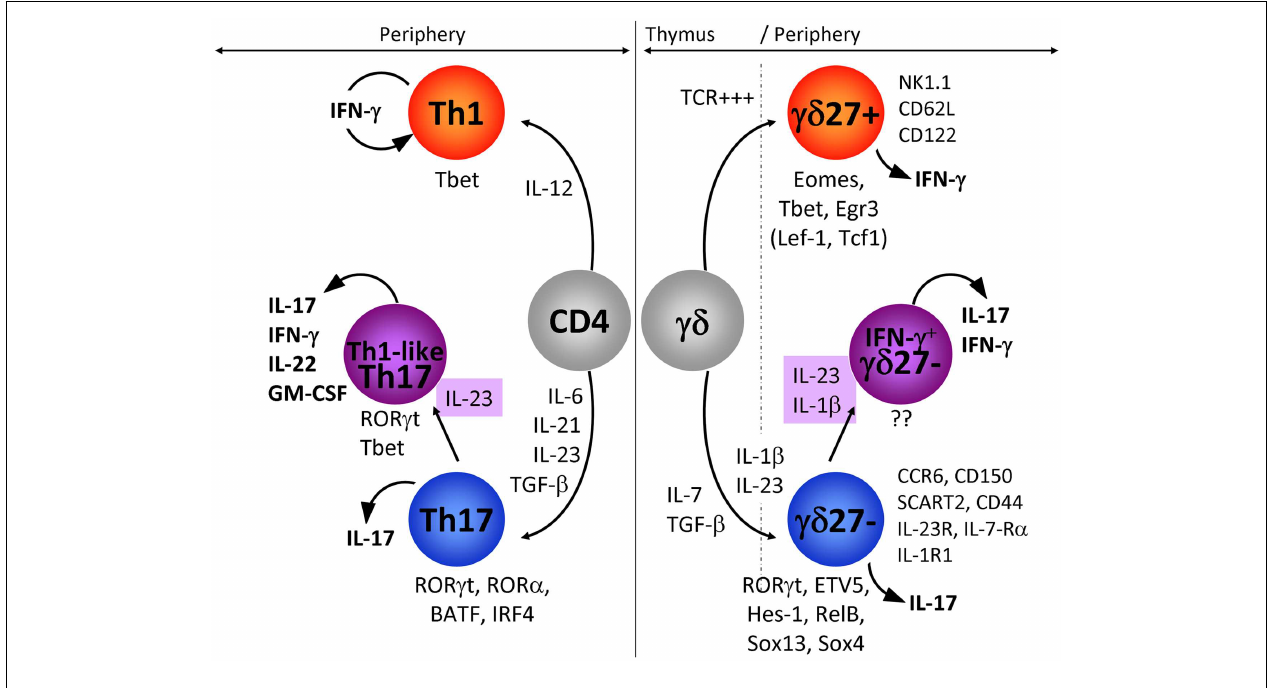
IFN- γ -producing γδ 27 + and IL-17-producing γδ 27 − T cells is detailed.The emergence of IL-17 + IFN- γ + T cells is highlighted for both CD4 and γδ T cells. Of note, the transcription factors in parenthesis (TCF1 and LEF1) below γδ 27 + T cells have been proposed to inhibit IL-17 production in these